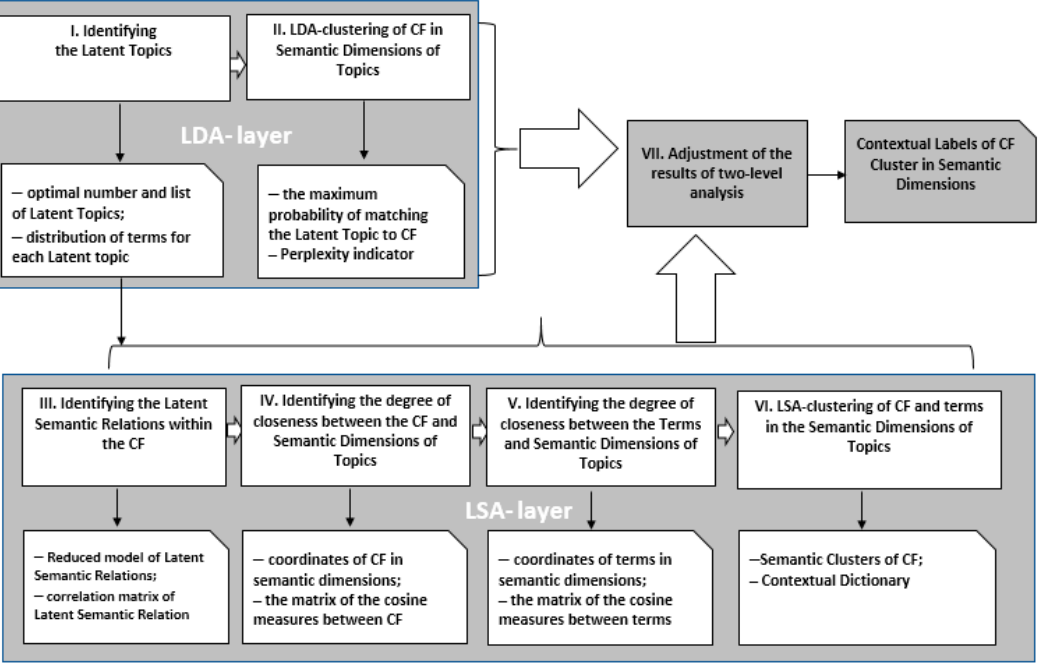
Figure 1. The steps of the latent semantic relations revealing phase. Source: own research results.